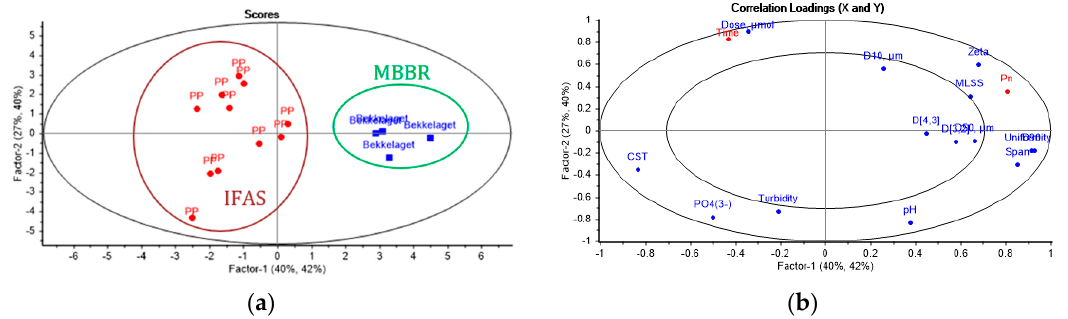
Figure 11. Scores plot ( a ) and correlation loadings plot ( b ) of the effects of chemical enhancer in Total Recycle Tests with Mixed Liquors from MBBR and IFAS.